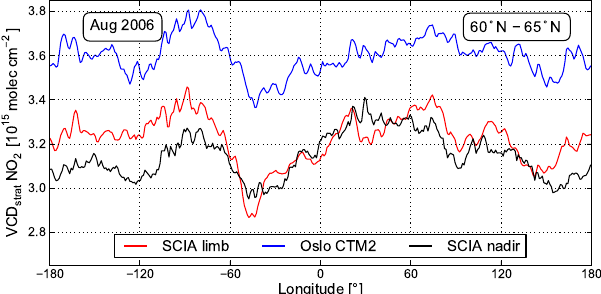
Fig. 4. Zonal variation of VCD limb strat from SCIAMACHY limb measurements (red), VCD mod strat from Oslo CTM2 simulations (blue), and of VCD nadir strat from SCIAMACHY nadir measurements. Monthly mean values for August 2006, between 60 ◦ and 65 ◦